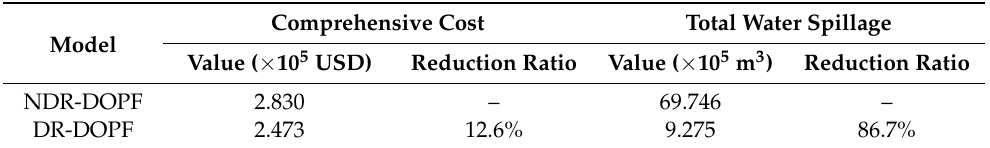
Table 2. Comparison of TN-DOPF and DR-DOPF results.